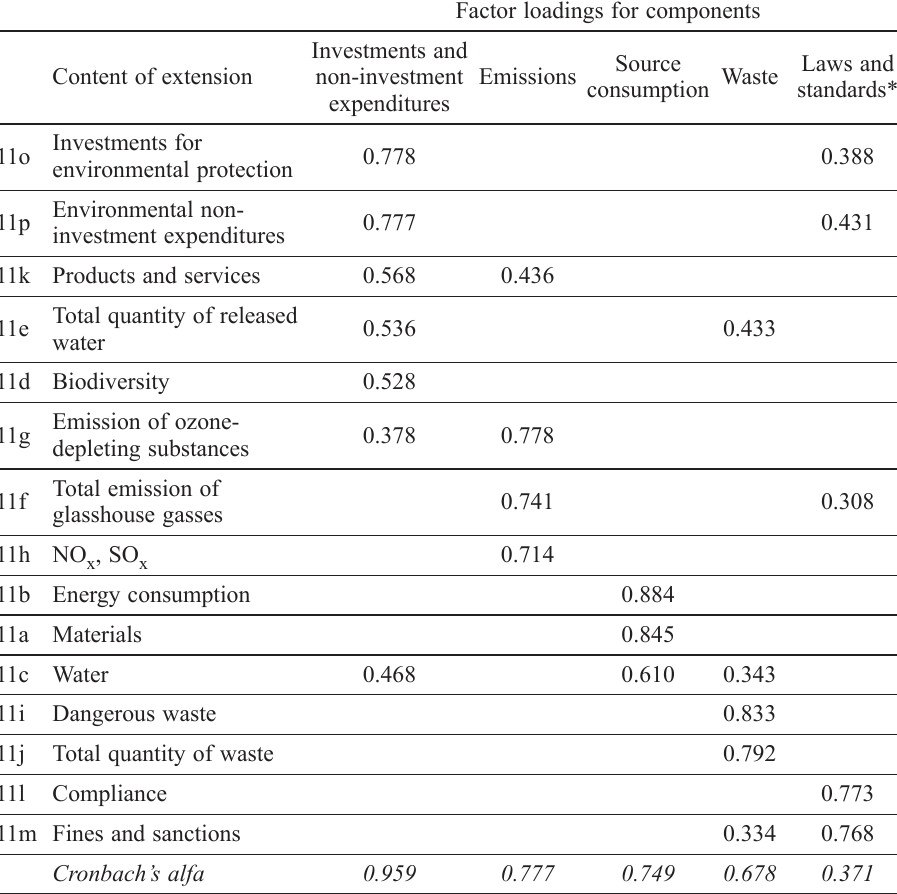
Table 2. Rotated component matrix for the extension contents Factor loadings for